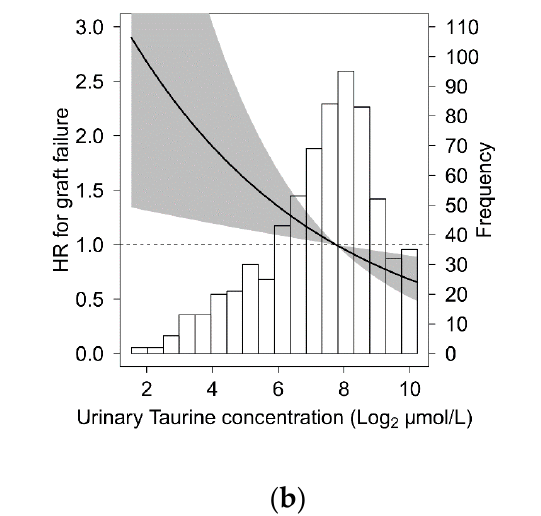
Figure 1. Continuous association of urinary taurine excretion ( a ), urinary taurine concentration ( b ) and urinary taurine / creatinine ratio ( c ) with death-censored graft failure. Urinary taurine excretion, urinary taurine concentration and urinary taurine / creatinine ratio were log 2 -transformed for prospective analysis. The histograms depict the distribution of urinary taurine excretion, urinary taurine concentration and urinary taurine / creatinine ratio. The black line shows the adjusted hazard ratio (HR) and the gray areas correspond to the 95% confidence interval (CI). The adjusted association was adjusted for age, sex, weight, height, eGFR and proteinuria. P values were 0.002, 0.007 and 0.01, respectively.